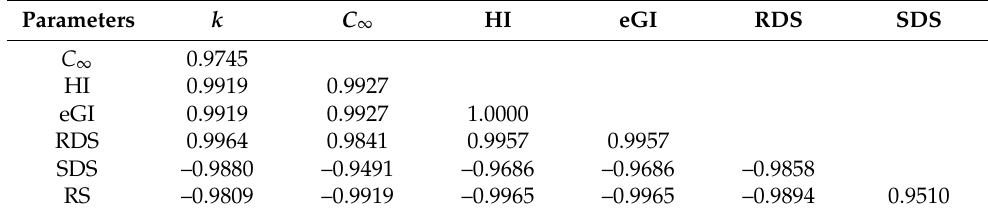
Table 3. Pearson correlations among the starch digestibility parameters for stored cooked rice.